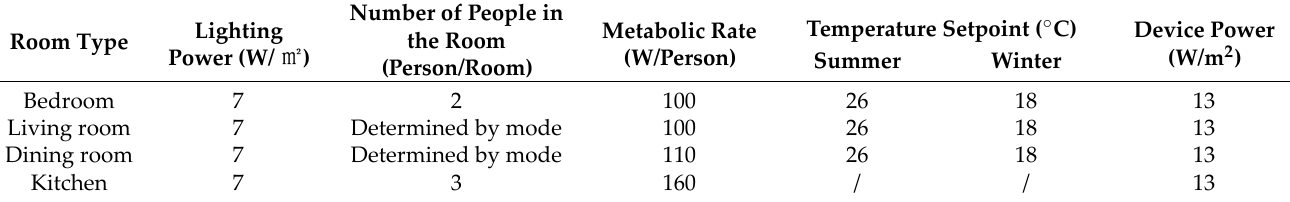
Table 2. The basic parameter settings in the building room.